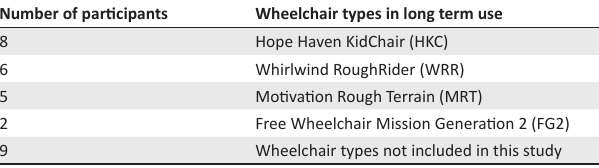
TABLE 1a: Number of participants who were long-term users of a type of wheelchair included in this study, and diagnoses of participants as provided by our partner